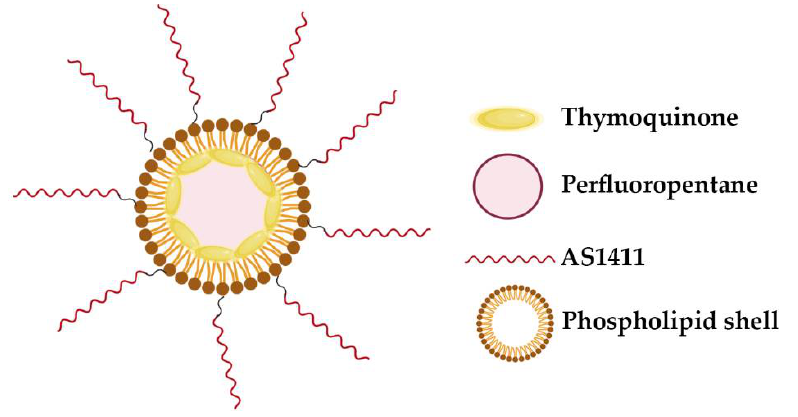
Figure 7. Schematic of AS1411-conjugated nano-droplets loaded with thymoquinone. The perfluorocarbon-based nano-droplet emulsions were coated with a phospholipid shell, formed by DPPC/DSPE-PEG2000 [86].